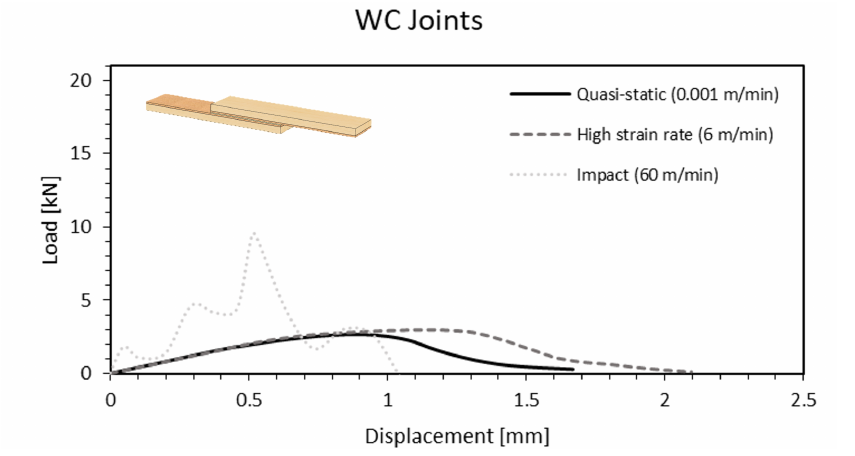
Figure 20. Load-displacement curve of a WC joint as a function of the cross-head